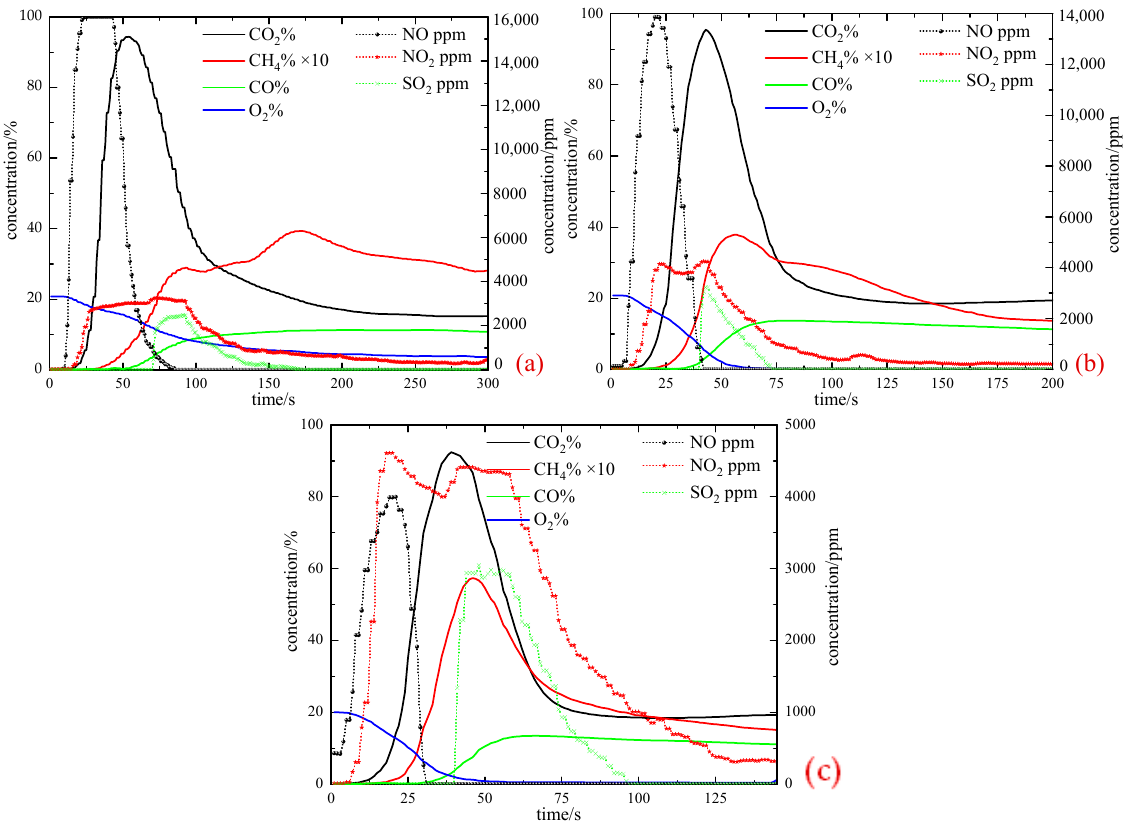
Figure 9. Flue gas analysis curves of the catalytic ignition process in a model thruster with the convergent nozzle at each flow rate: ( a ) 1 mL/min; ( b ) 2 mL/min; ( c ) 3 mL/min.